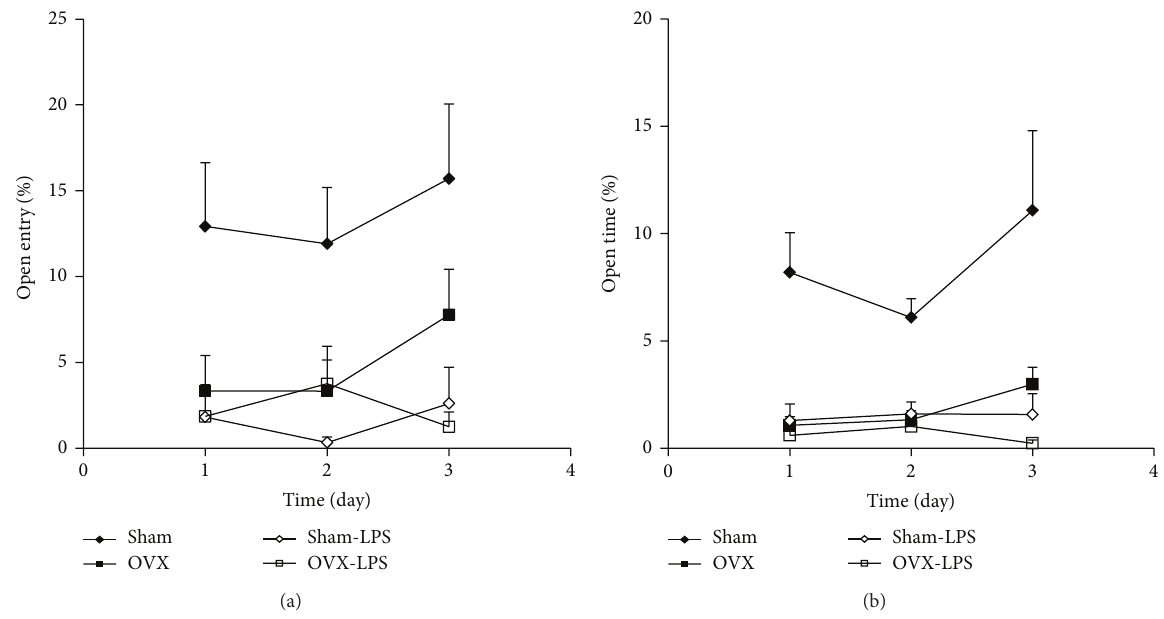
Figure 5: Comparison of the percent number of entries to the open arm (a) and the percent of time spent in open arm (b) in the elevated plus maze test between four groups. Data are expressed as mean ± SEM ( 𝑛 = 10 in each group). The percent number of entries into and the percent of time spent in the open arm by the animals of OVX and Sham-LPS groups were lower than that of Sham group ( 𝑃 < 0.01 – 𝑃 < 0.001 ). There were no significant differences between OVX-LPS and OVX